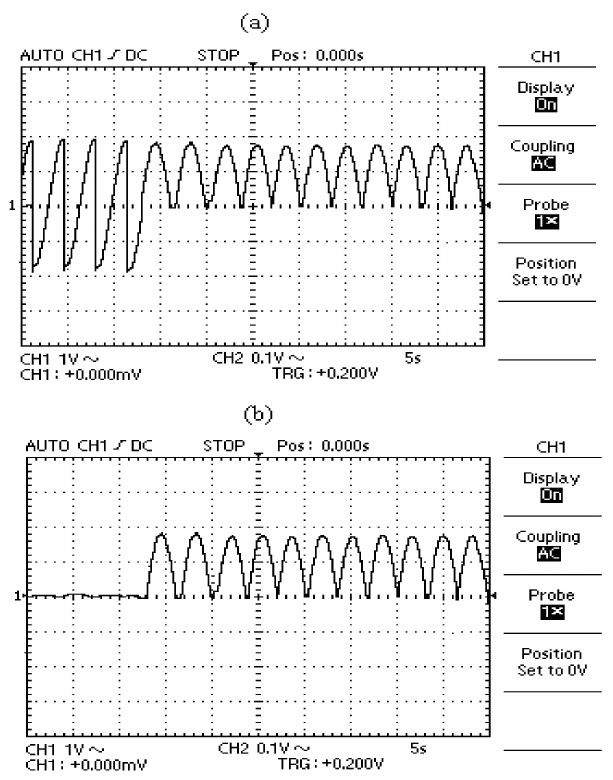
Figure 11. CDBFCL ( a ) shunt and ( b ) series bridges